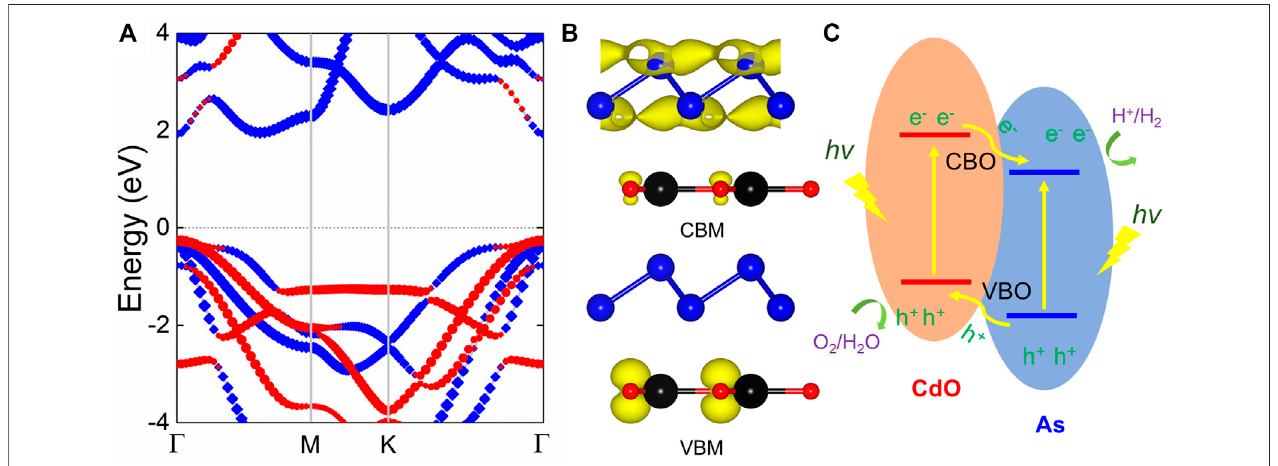
FIGURE 5 | The p – n heterostructure schematic illustration: (A) before combining, (B) in combining, (C) transformation of photogenerated charge carriers in p – n heterostructure, and (D) suppressed transformation of photogenerated charge carrier in direct Z-scheme style.